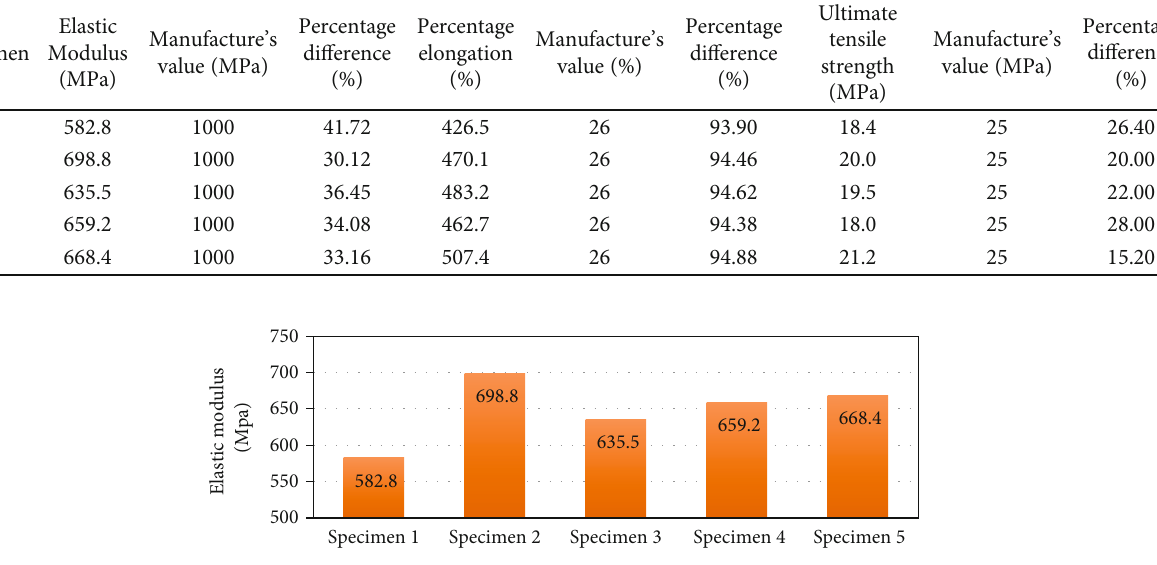
Figure 5: Comparison of the elastic modulus for the printed